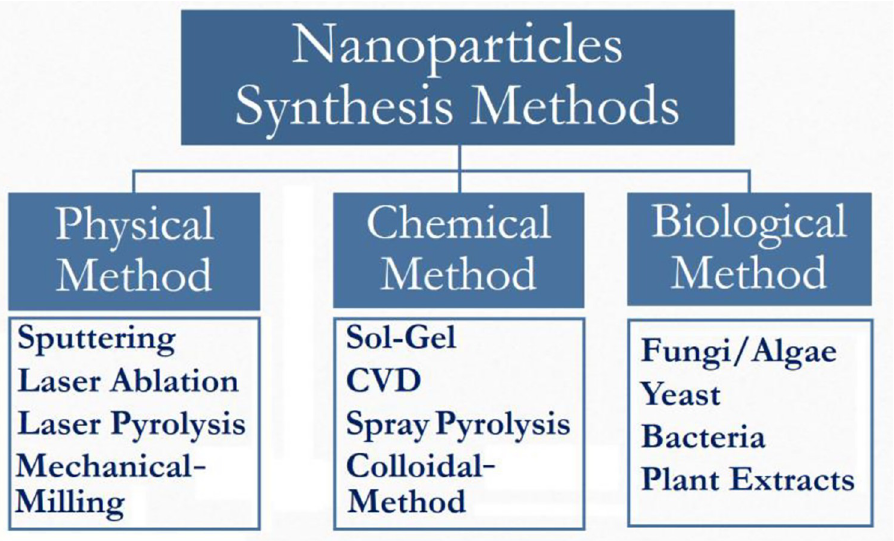
Fig 2. Nanoparticles can be synthesized through physical, chemical, and biological processes.